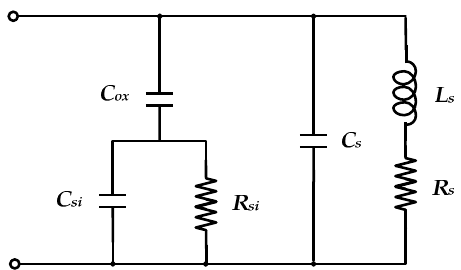
Figure 1. Lumped physical model of the spiral inductor.